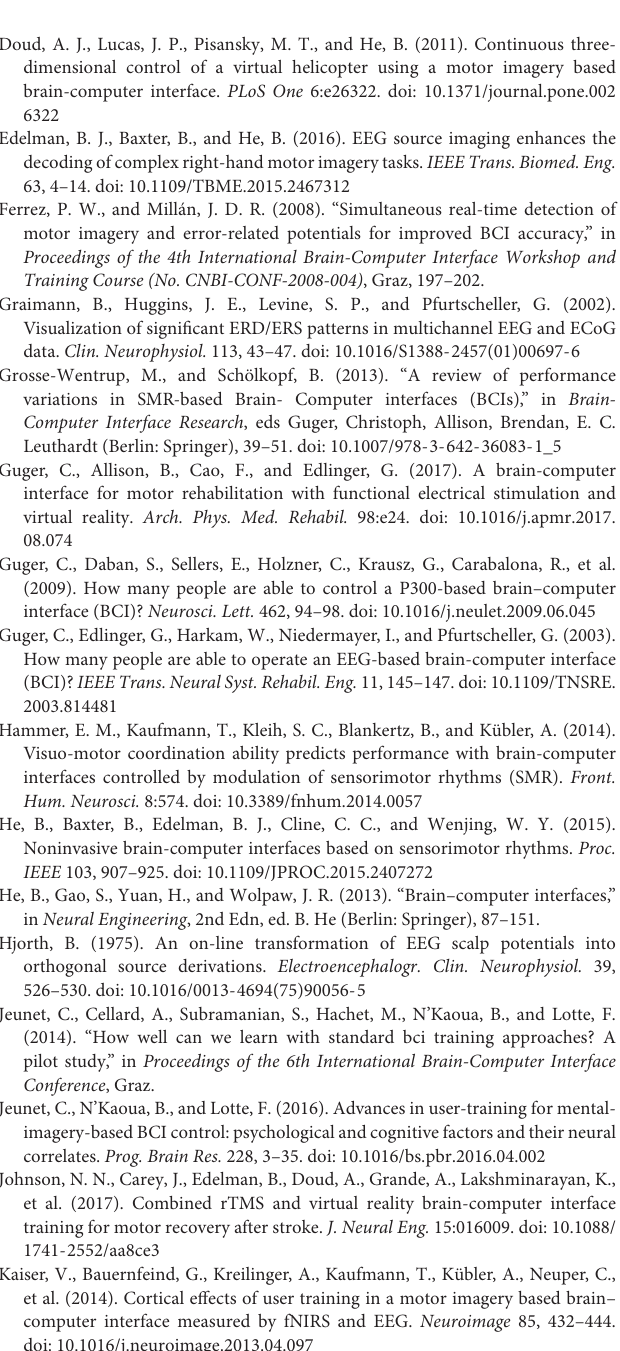
group average results. Strong but separable ERSs on both of the contralateral and the ipsilateral hemisphere were observed especially in the latter two sessions. FIGURE S3 | An individual example (Subject 25) of the time varying average ERD/ERS value for the right hand task (the first row) and the left hand task (the second row) across the training sessions. Shown is the similar convention to the group average results. A very weak ERD on the contralateral hemisphere and a very strong ERS on the ipsilateral hemisphere was observed in all of three